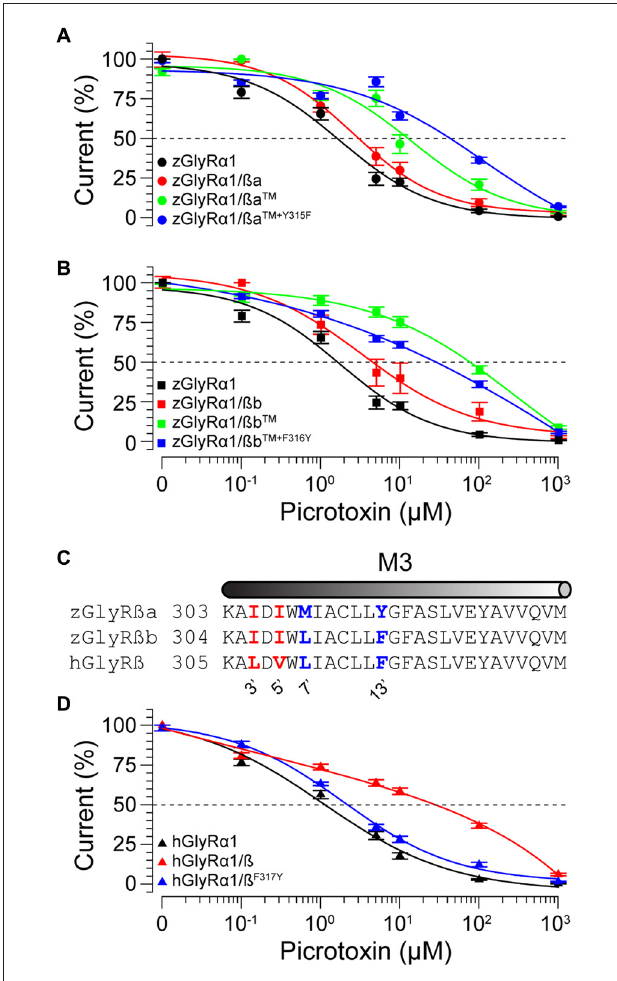
FIGURE 6 | Residues within M2 and M3 of zebrafish and human ß subunits contribute to picrotoxin resistance. Cumulative effect of amino acid substitutions on picrotoxin-mediated blockade of zGlyRßa (A) , zGlyRßb (B) , and hGlyRß containing receptors (D) . TM: triple mutation of residues in M2 of zGlyRß subunits; ßa: L280F+S286A+S291T, ßb: L281F+S287A+S292T. Ten oocytes were used for each assay. (C) Sequence alignments of M3 from hGlyRß and zGlyRß subunits. Red and blue letters indicate residues that are conserved between zGlyRß subunits, and zGlyRßb and hGlyRß,